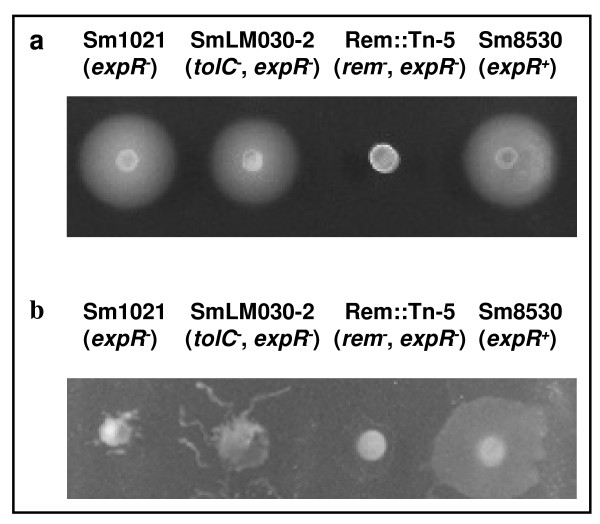
Swimming (a) and swarming (b) tests. Swimming and swarming plates containing 0.3% and 0.6% purified agar, respectively, were spotted with 5 μl of late exponential S. meliloti cultures grown overnight in GMS medium. The photographs were taken after 1 day of incubation for swarming and 3 days for swimming at 30°C.